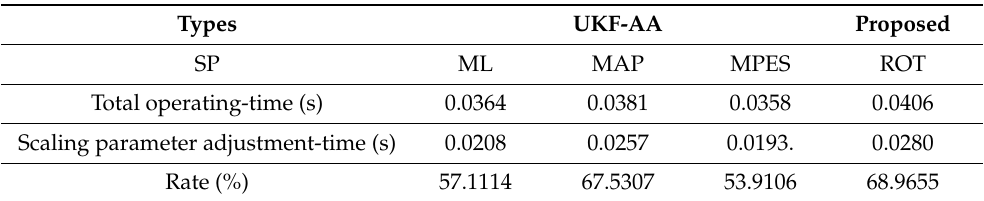
Table 4. Operating ‐ time of the filter performance.